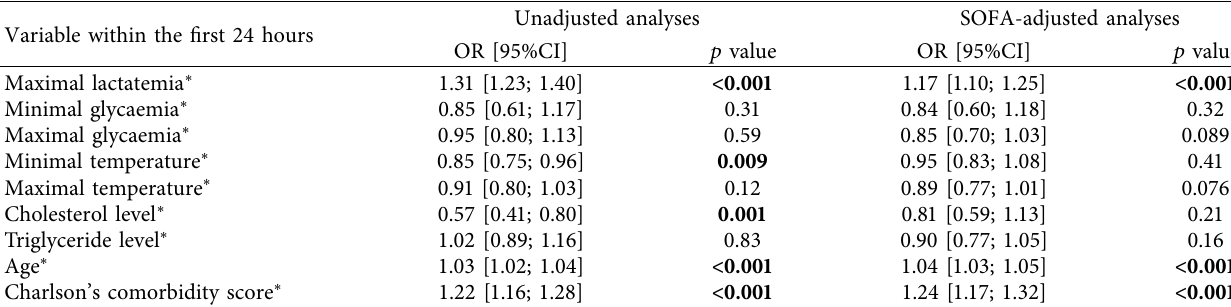
Table 2: Unadjusted and SOFA-adjusted odds ratio for in-hospital mortality within 90 days of intensive care